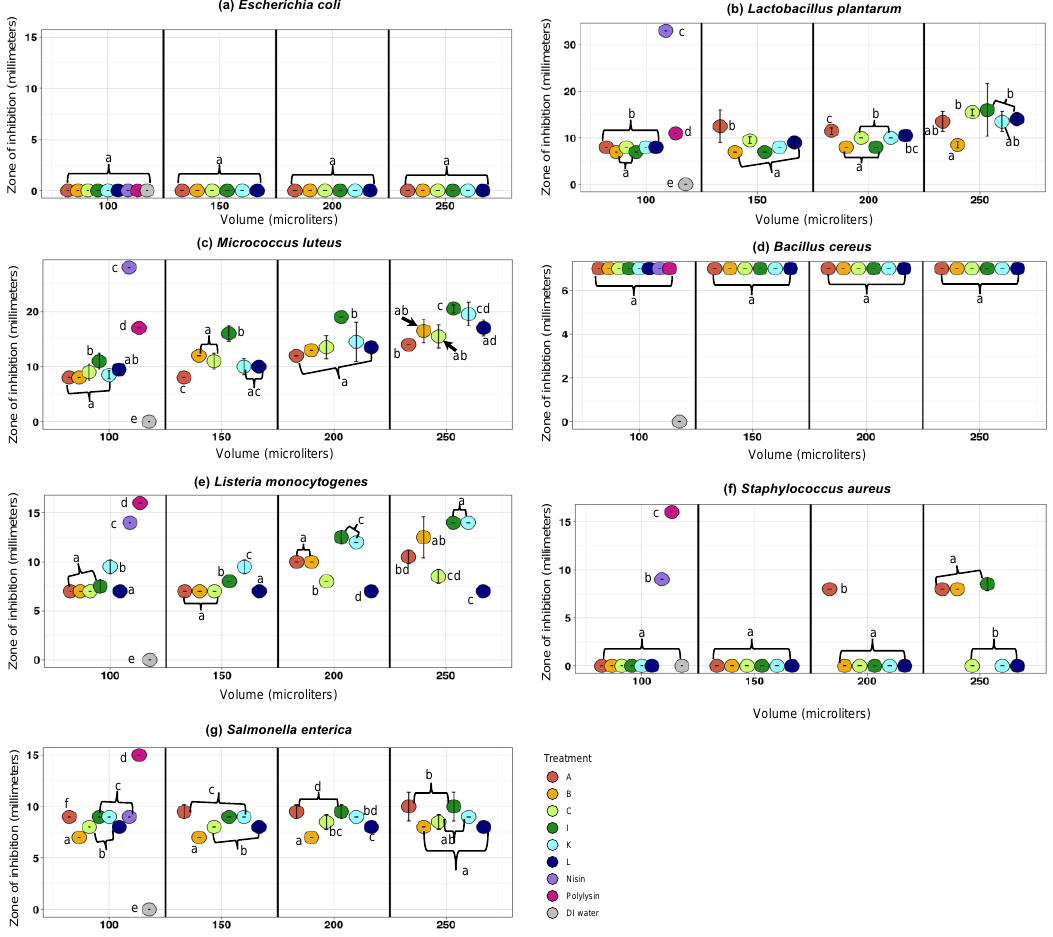
Figure 1. Comparison of the antimicrobial activity spectra of artisanal kefirs from Fusion Tea (A, Amazon); Britain (B); the Caucasus region (C); Ireland (I); South Korea (K); and Lithuania (L) against ( a ) Escherichia coli ATCC 12435, ( b ) Lactobacillus plantarum NCDO 995, ( c ) Micrococcus luteus ATCC 10420, ( d ) Bacillus cereus ATCC 14579, ( e ) Listeria monocytogenes CWD 1198, ( f ) Staphylococcus aureus ATCC 25923, and ( g ) Salmonella enterica serovar Enteritidis ATCC 13076 using the agar well diffusion method. A range of filter-sterilized artisanal kefir volumes (100 µL, 150 µL, 200 µL, and 250 µL) were placed inside the wells. Nisin (N; 220 IU) and polylysin (P; 200 IU) were used as positive controls in a volume of 100 µL. Sterilized DI water (100 µL) was used as a negative control. The diameter of the inhibition zones was measured in mm. All experiments were conducted two independent times and each time in duplicate. Different letters (a–f) indicate statistical pairwise comparisons between the treatments within each volume performed by post-hoc Tukey’s multiple comparison procedure. The same letter indicates no significant difference between the treatments within each volume.